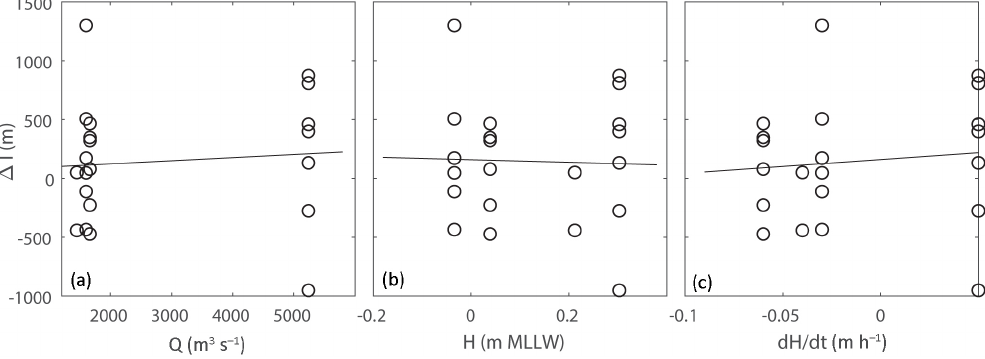
Figure 7. Comparison of (cid:49)l measurements on the WLD to unsteady hydrodynamic conditions. In each case, the black line shows the linear trend, which is negligible. (a) Upstream water discharge, with r 2 = 0 . 01. (b) Tidal elevation relative to mean lower low water with r 2 = 0 . 001. (c) Rate of change of tide elevation averaged over 30min with r 2 = 0 .